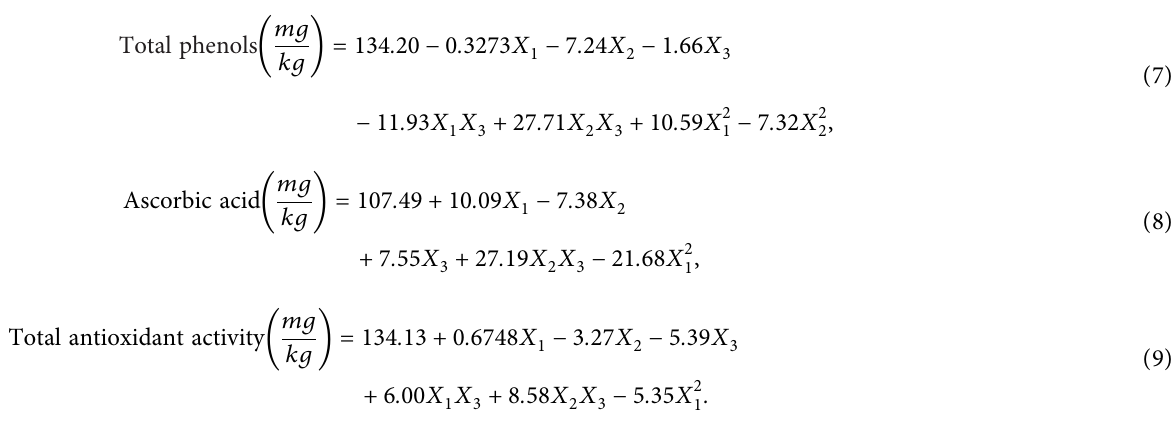
Supplementary Table 7: ANOVA for response surface re- duced quadratic model of the ascorbic acid levels of beeswax coating. Supplementary Table 8: ANOVA for response surface reduced quadratic model of the total antioxidant capacity of beeswax coating. ( Supplementary Materials